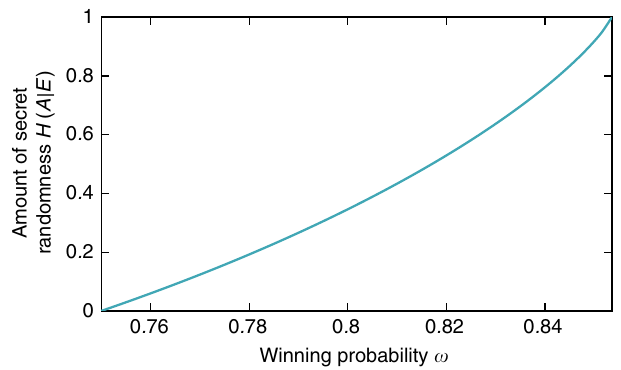
Fig. 2 Secrecy for the Clauser – Horne – Shimony – Holt game vs. winning probability. The amount of secret randomness is quanti fi ed by the conditional von Neumann entropy H A E jð Þ . As soon as the winning probability is above the classical threshold of 75% some secret randomness is produced. The analytical bound 19 is stated as Eq. (2)